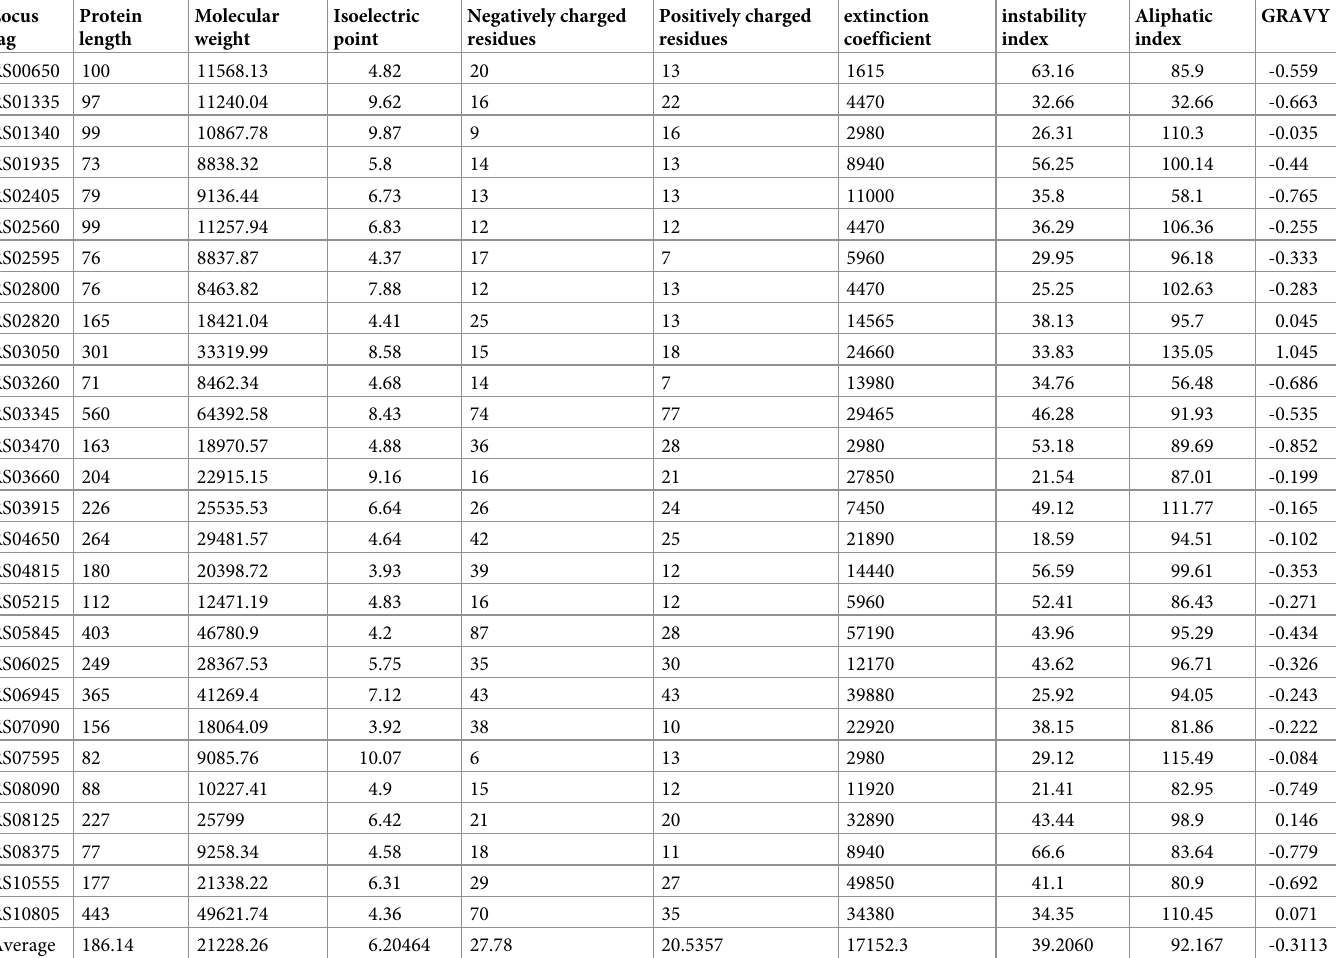
Table 2. Physicochemical properties of HPs obtained using ProtParam